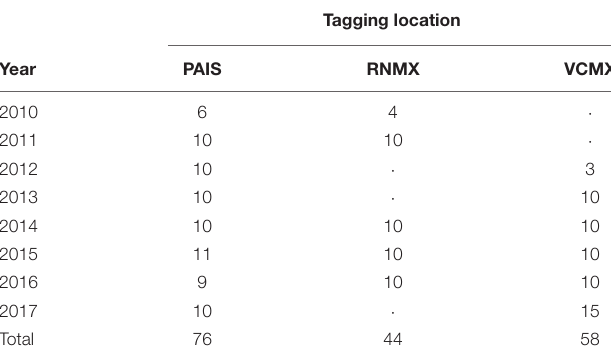
TABLE 1 | Tagging locations and years for satellite transmitters deployed between 2010 and 2017 of 178 post-nesting female Kemp’s ridley sea turtles tracked from the primary and major secondary nesting beaches: Padre Island National Seashore, Texas, United States (PAIS); Rancho Nuevo, Tamaulipas, Mexico (RNMX); Tecolutla, Veracruz, Mexico